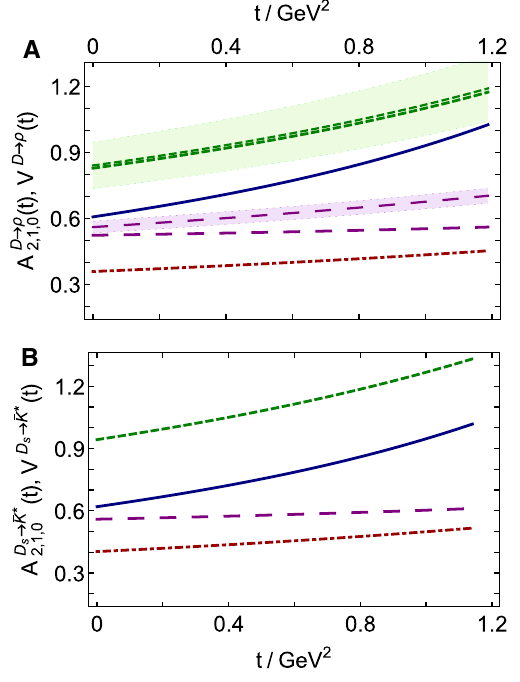
Fig. 1 A D → ρ transition form factors. SCI predictions: A 2 ( t ) – dot-dashed red curve; A 1 ( t ) – long-dashed purple; A 0 ( t ) – solid blue; V ( t ) – dashed green. Thinner, like-texture and -colour curves within shaded bands are elementary monopole fits to data drawn from Ref. [73, CLEO]. B SCI predictions for D s → ¯ K ∗ transition form factors, with associations as in A . In this case, no comparable empirical form factors are available